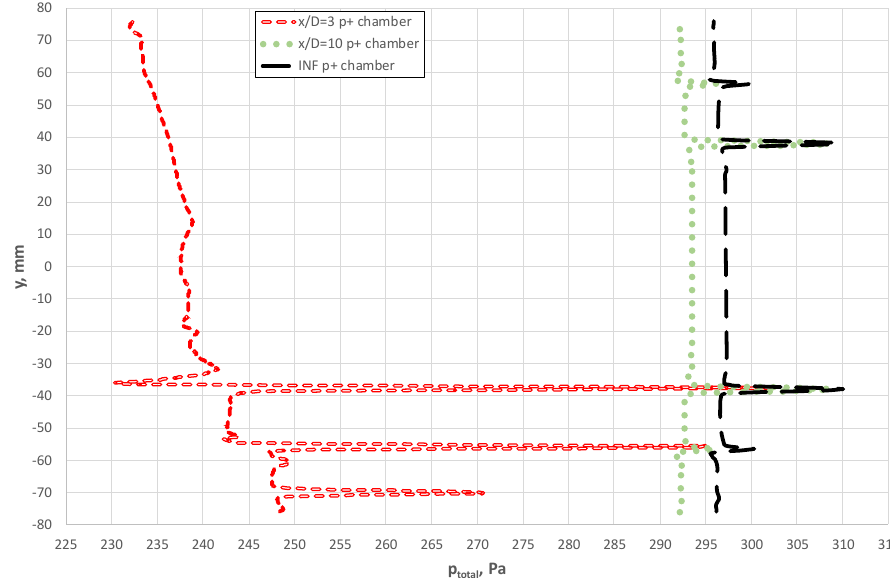
Figure 15. Total pressure along the axis of the p + chamber at various distances between the probe and the